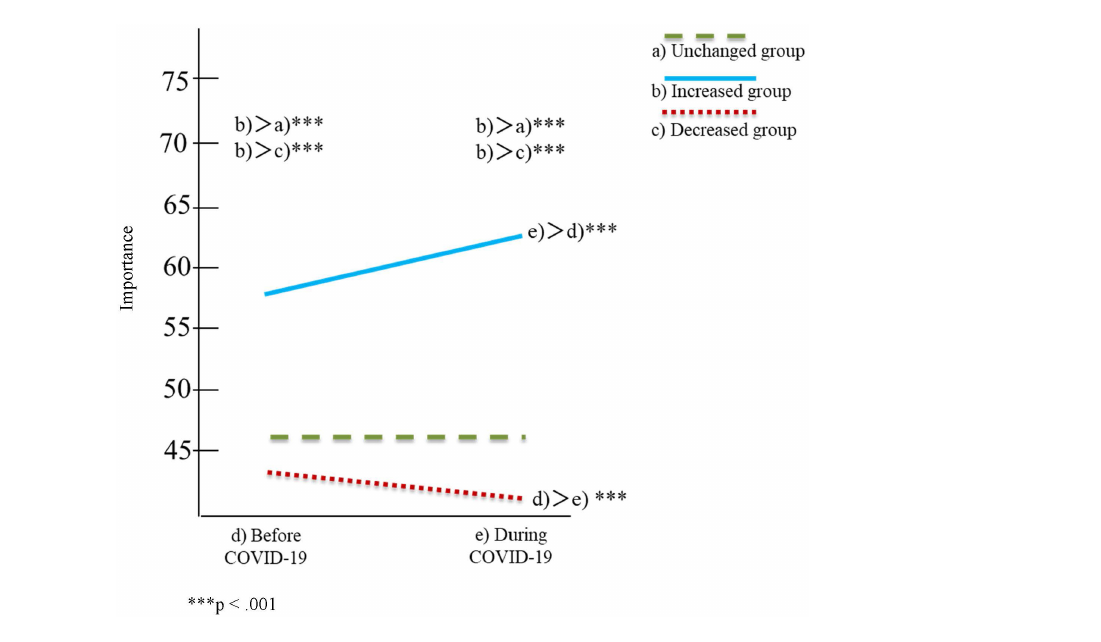
FIGURE2 Time spent with others for daily